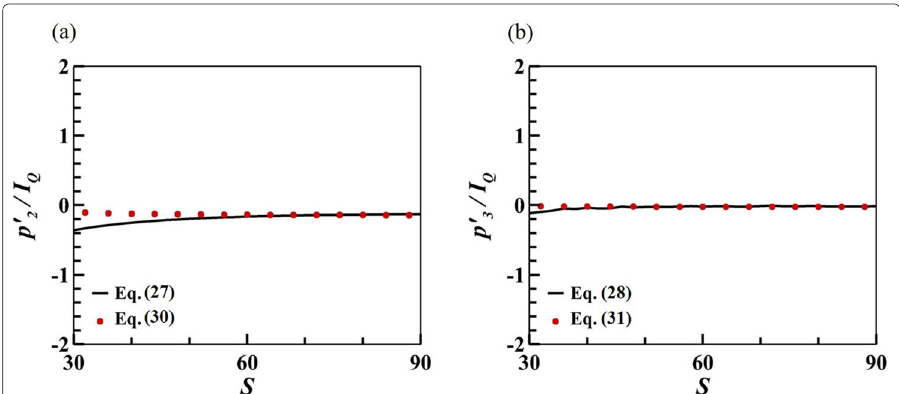
Fig. 4 Sound pressures correspond to ( a ) the second term and ( b ) the third term at different observer distances S . The sound pressures corresponding to the second term are computed by using the Eqs. (27) and (30), respectively. The sound pressures corresponding to the third term are computed by using the Eqs. (28) and (31), respectively. The sound pressures at the non-time dimensional time t = 120 are plotted. The convecting Mach number of the vortex is M a = 0.2 and the observers are distributed along the line with θ = 0 ◦